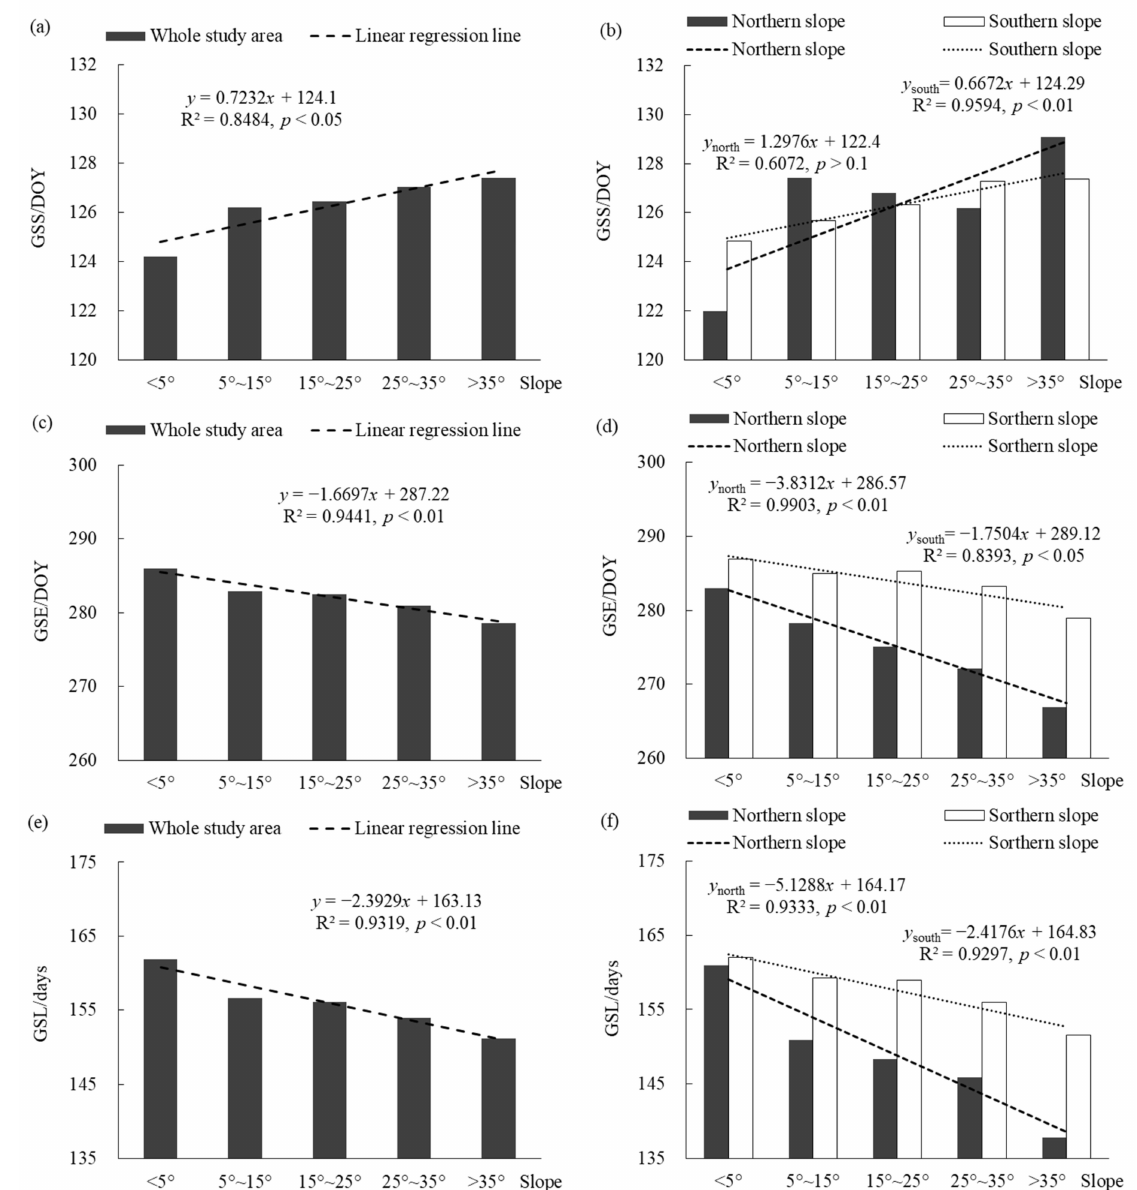
Figure 7. Changes of vegetation phenological parameters on the different slopes in Niubeiliang Reserve from 2000 to 2017. The horizontal coordinate was specifically the flat slope (below < 5 ◦ ), gentle slope (5 ◦ –15 ◦ ), sloping slope (15 ◦ –25 ◦ ), steep slope (25 ◦ –35 ◦ ), and sharp slope (>35 ◦ ). ( a ) GSS of the whole area with the slope; ( b ) GSS of the northern and southern slopes with the slope; ( c ) GSE of the whole area with the slope; ( d ) GSE of the northern and southern slopes with the slope; ( e ) GSL of the whole area with the slope; ( f ) GSL of the northern and southern slopes with the